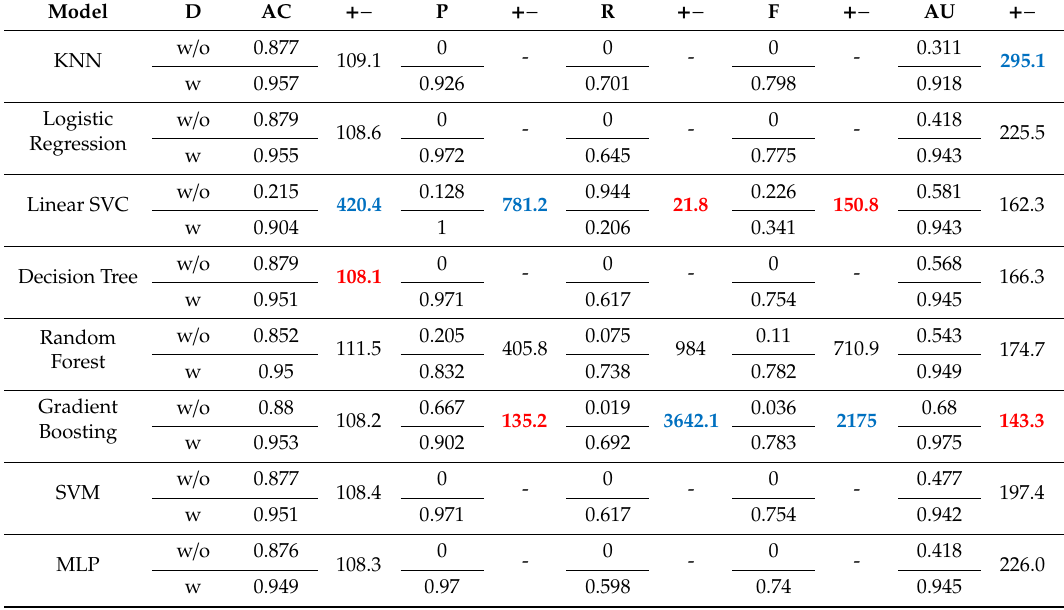
Table 7. Change rate of increase and decrease according to feature (Dataset